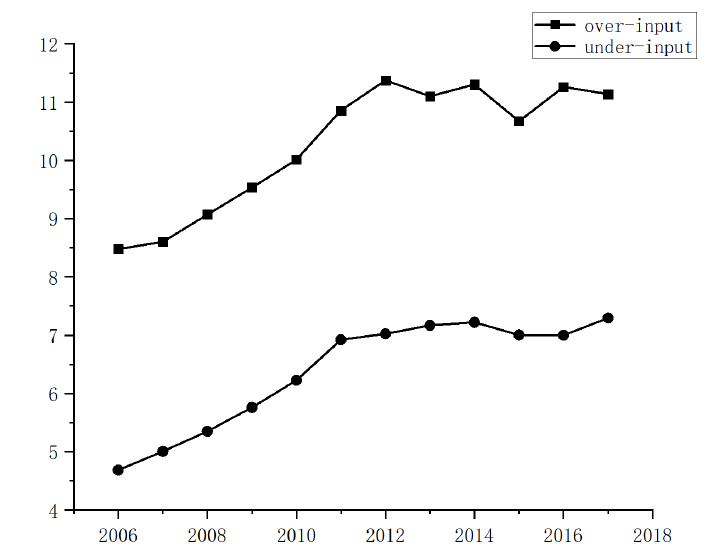
Figure 2. Difference in CO 2 emissions per capita between the over-input and the under-input